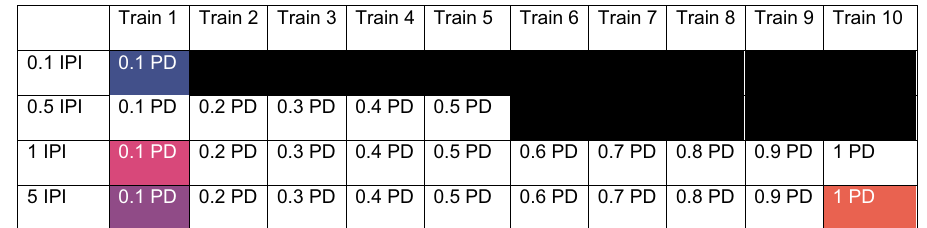
Table 1. Parameters of light pulse trains. The inter-pulse intervals (IPI) and pulse durations (PD) used to stimulate the diaphragm were systematically varied across ten stimulus trains. Parameters were not used if they exceeded a 50% duty cycle (black boxes). The colored boxes indicate the IPI/PD combinations that were selected for comprehensive testing in experiment